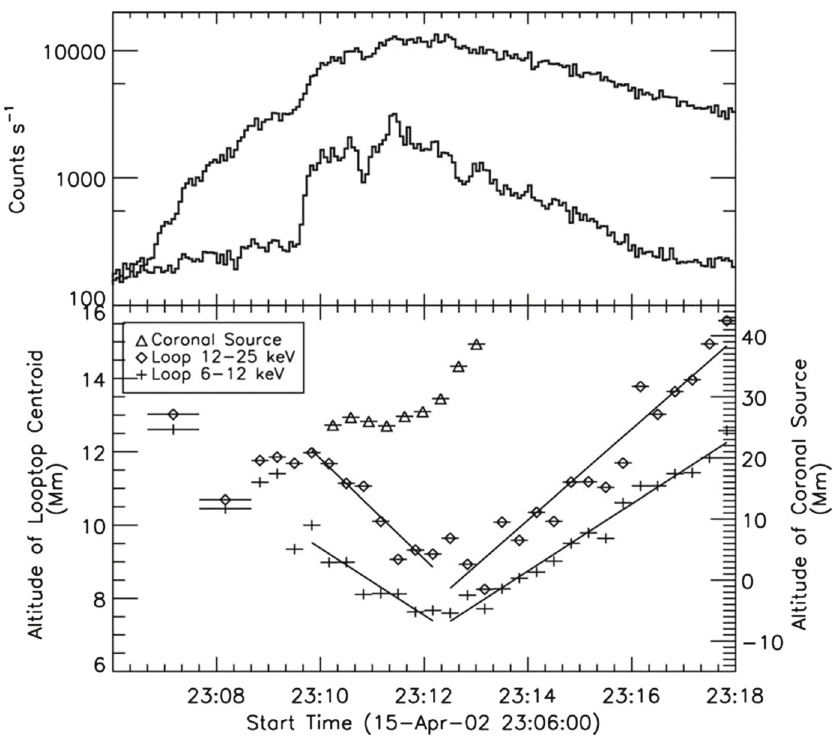
Fig. 28 Top light curves in two X-ray energy bands ( upper curve 6–12 keV; lower curve, 25–50 keV) for SOL2002-04-15 as observed by RHESSI. Bottom altitude of the loop-top centroid obtained using the 60% contour for the images in the 6–12 ( crosses ) and 12–25 keV ( diamonds ) bands. The triangles show the altitudeofthelowersourceabovetheflareloop.The horizontalbars oneachpointrepresentstheintegration time of the corresponding image. The lines show linear fits to the altitudes versus time for two time ranges and two energy bands. Image reproduced by permission from Sui et al. (2004), copyright by